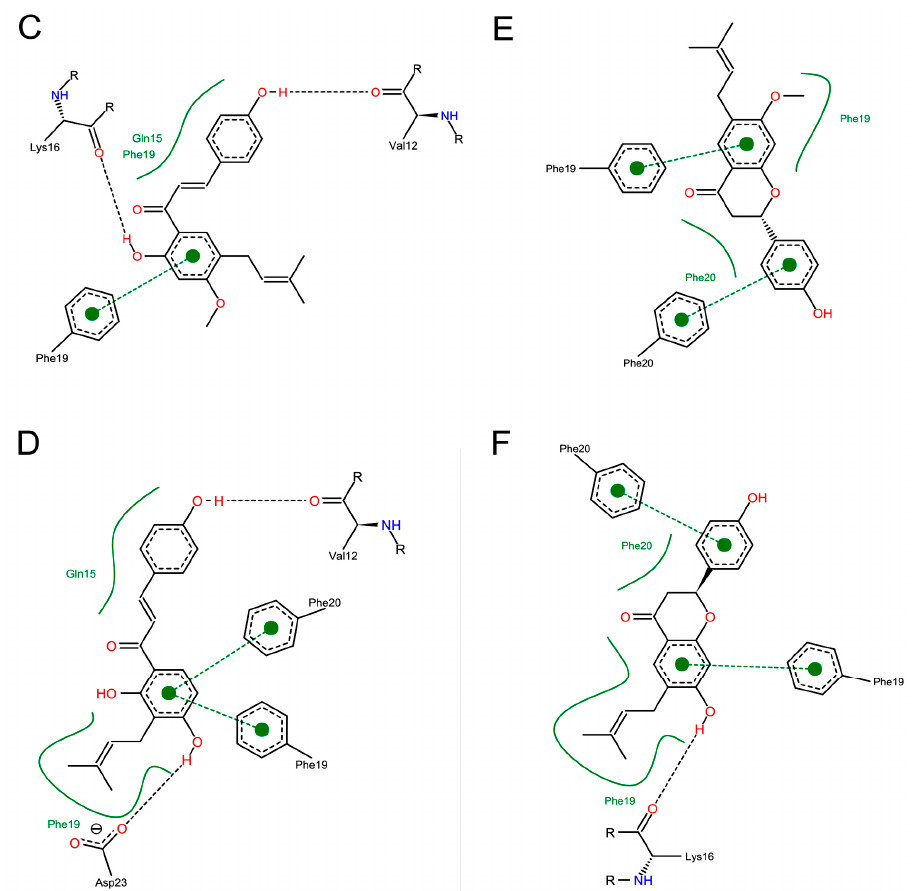
Figure 6. Docking studies of PF compounds and A β 42 monomer. The PF molecules were docked into the whole surface of A β 42 monomer (1Z0Q) using Autodock Vina. The best docking poses were viewed using Pymol and PoseView. The binding modes are shown for ( A ) bavachalcone & isobavachalcone and ( B ) bavachin & bavachinin, binding at the central hydrophobic cluster K 16 LVFF 20 . The possible interactions are shown for ( C ) bavachacone, ( D ) isobavachalcone, ( E ) bavachinin, and ( F ) bavachin.